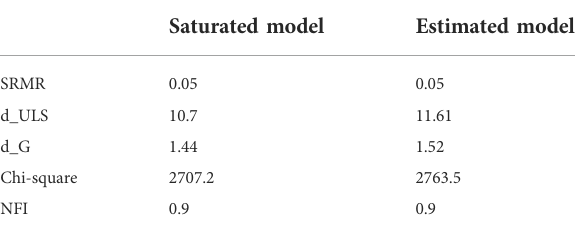
TABLE 9 Goodness-of- fi t index calculation. TABLE 10 Model fi t